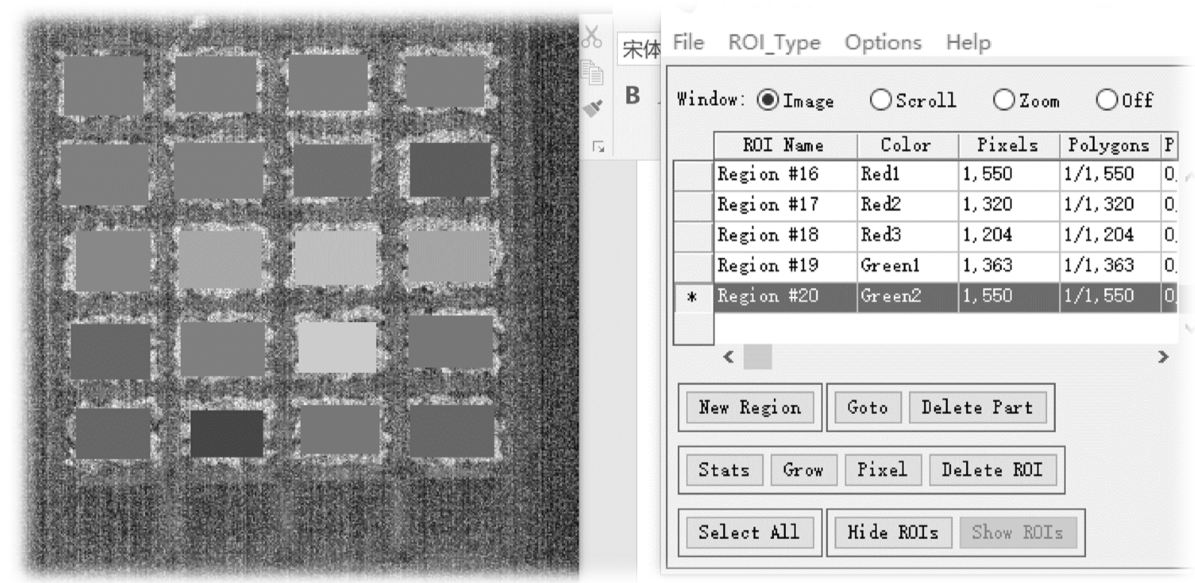
Figure 2. Fluorescence hyperspectral image of tea.